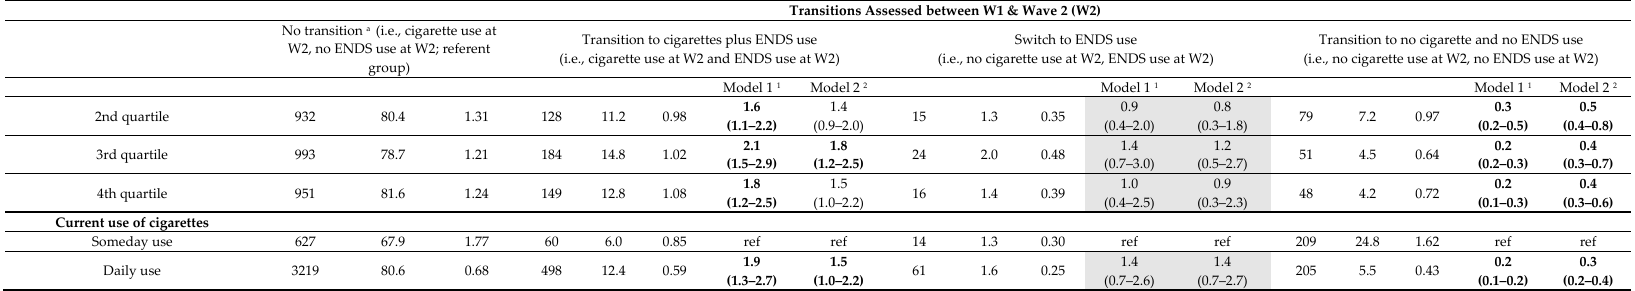
Table 1. Correlates of transitions in tobacco product use among ‘any tobacco’ users at Wave 1 (W1) of the Population Assessment of Tobacco and Health (PATH) Study ⱡ Table 2 notes. Sample includes adults aged 18+ years who were ‘exclusive cigarette’ smokers at W1 and also participated in W2 (N = 4893); analyses weighted using W2 longitudinal weights. Results from multinomial logistic regression analyses indicate the relative probability of being in each W2 transition group vs the W2 ‘no transition’ group as a function of correlates assessed at W1. Current use at each wave defined for cigarettes as having smoked at least 100 cigarettes in lifetime and now smoking everyday or somedays; for hookah as now using everyday, somedays, or monthly; for all other products as now using everyday or somedays. ‘Exclusive cigarette’ use defined as current use of cigarettes and no current use of any other tobacco product. Bold font indicates significant association at α = 0.05; grey shaded cells indicate unstable estimate due to denominator <50 or relative standard of the estimate >30%. 1 Analyses adjusted for age, sex, sexual orientation, race/ethnicity, education, and poverty level. 2 Analyses adjusted for age, sex, sexual orientation, race/ethnicity, education,